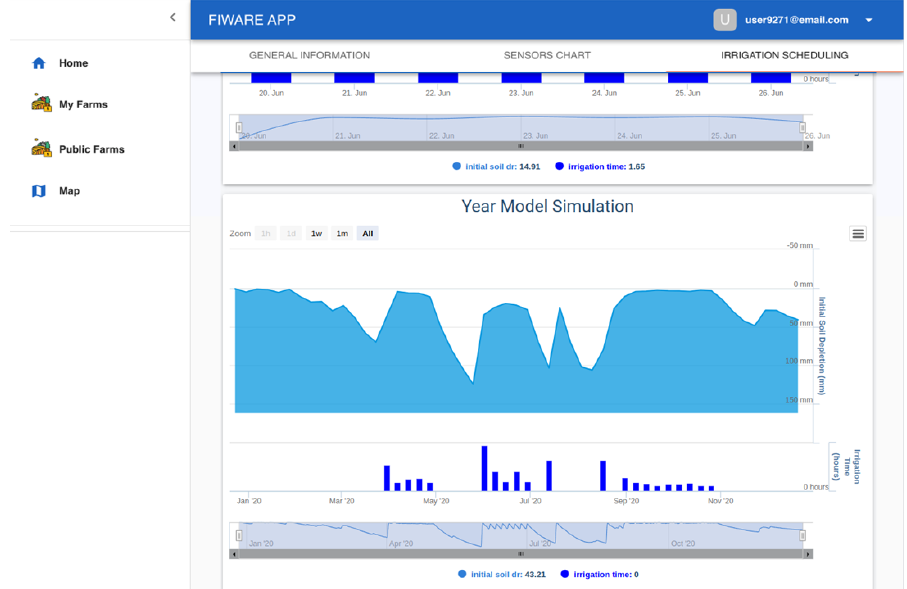
Figure 11. Annual simulation of the irrigation model showing water depletion in the root zone when using the RDI strategy defined in Figure 10 for a high-density olive grove.